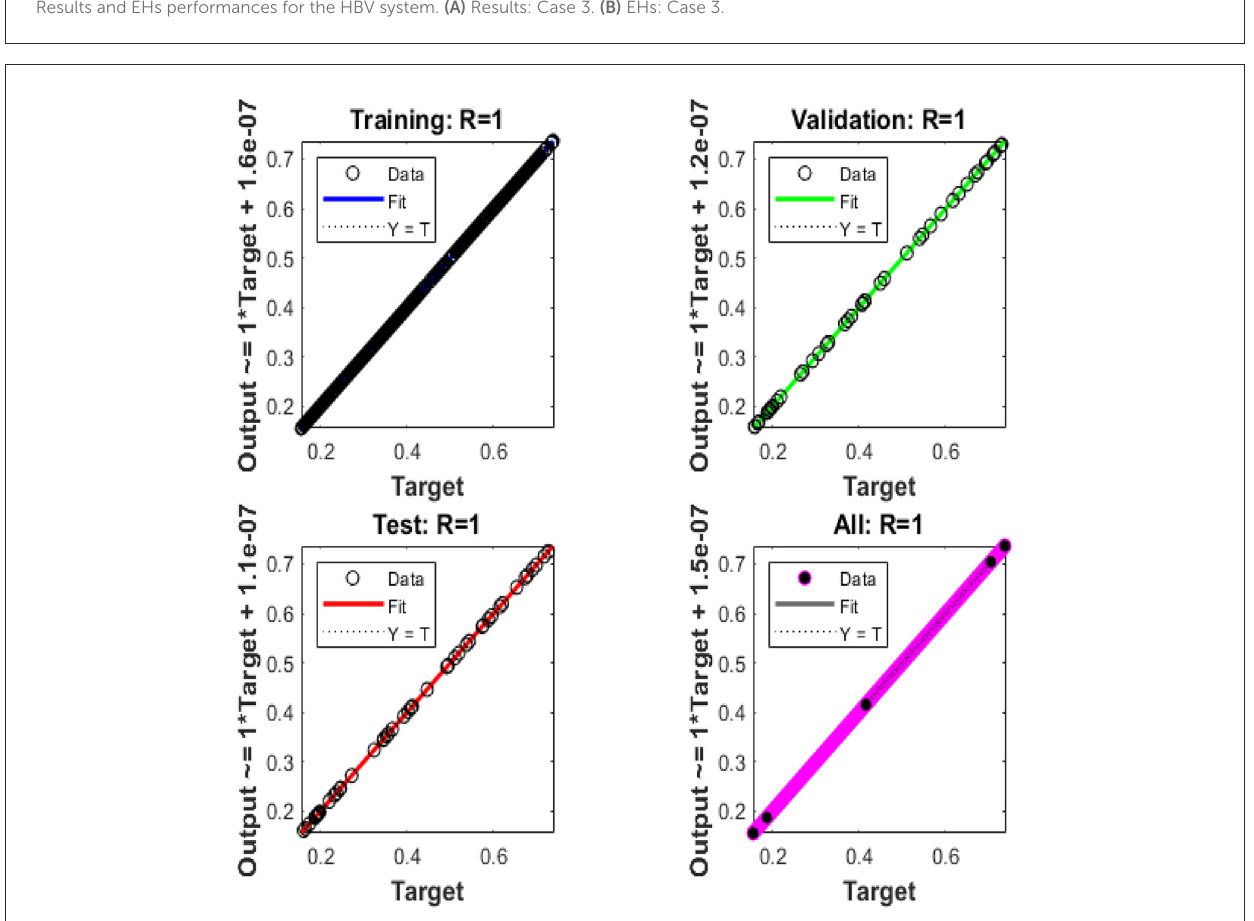
FIGURE10 Regression performances for the HBVNS model: Case 3.